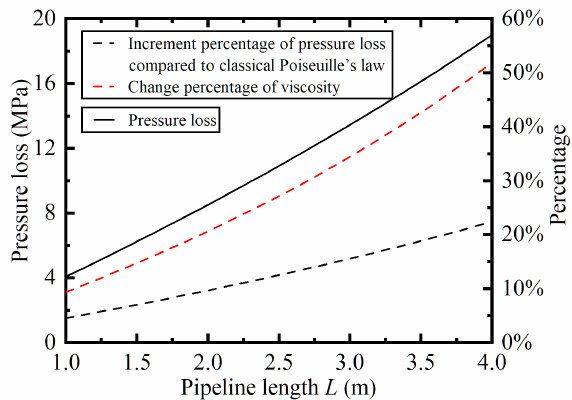
Figure 12. Pressure loss versus pipeline length.